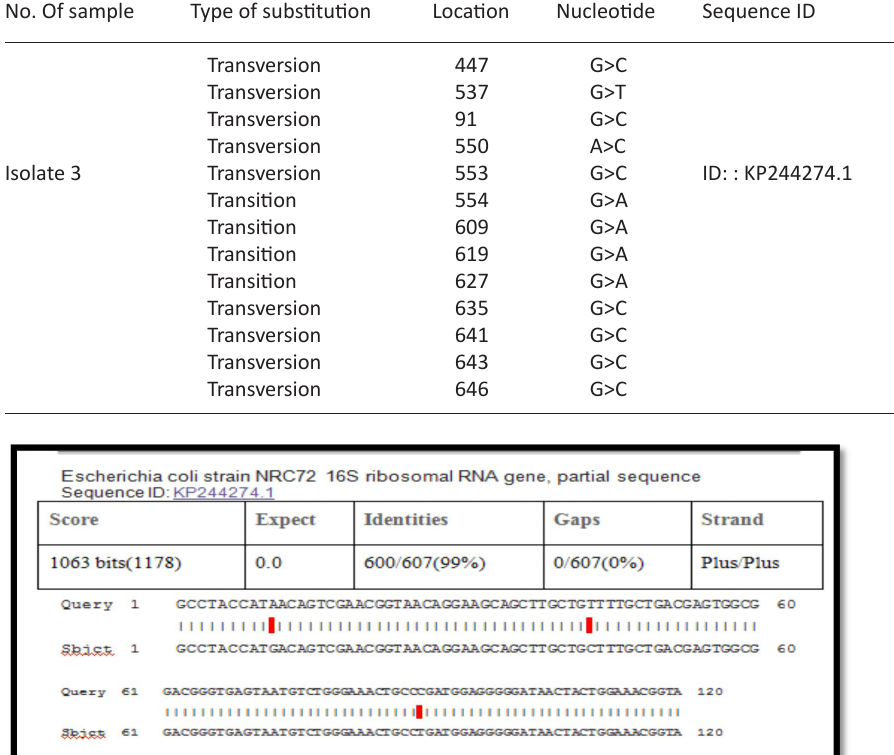
Table 3. Represent type of polymorphism of 16S rRNAgene from E. Coli